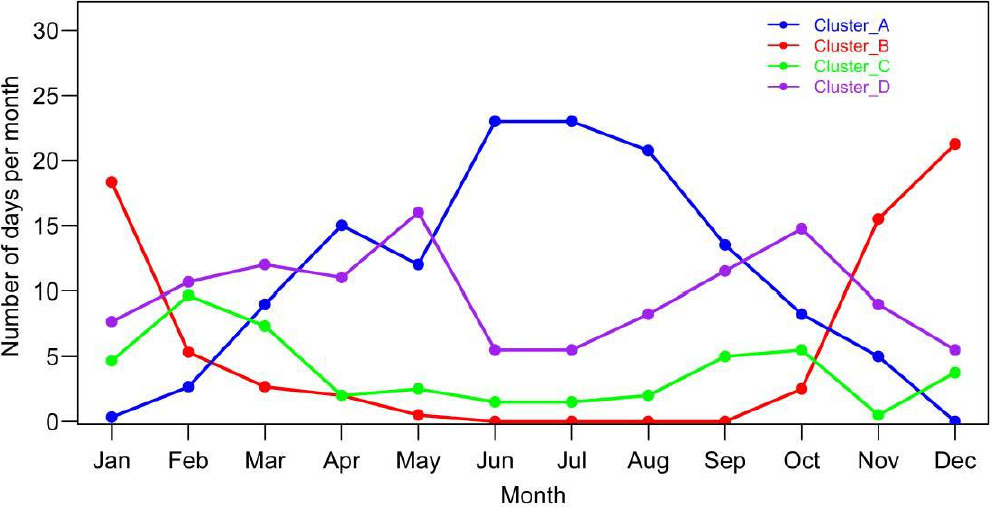
Figure 11. Seasonal frequency of retro-plumes associated at each cluster (A–D).